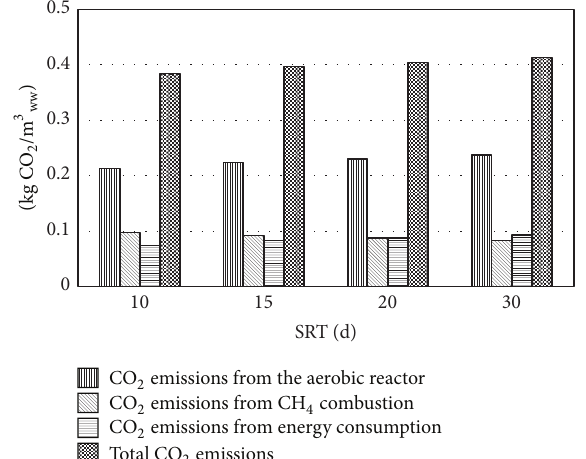
Figure 2: CO 2 emissions estimated for a conventional WWTP operated at different SRT